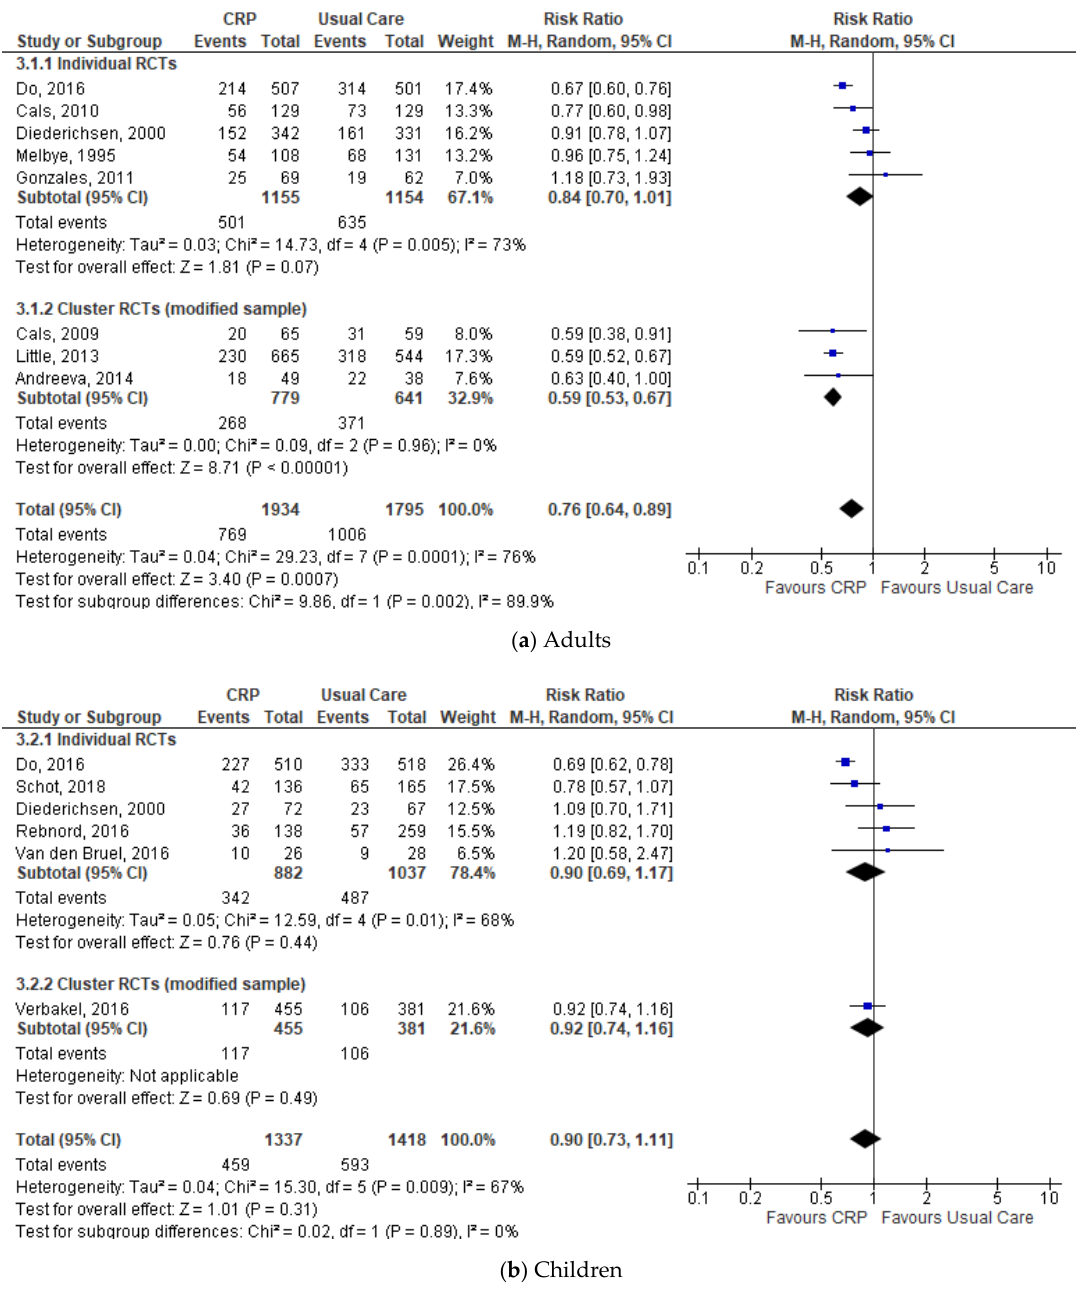
Figure 4. Comparison: CRP-POCT versus usual care. Antibiotic prescribing at index consultations by age group: ( a ) Adults; ( b ) Children. CRP, C-Reactive Protein Point Of Care Test; RCTs, Randomised Controlled Trials; M-H, Mantel-Haenszel; CI, Confidence Interval; df, degrees of freedom; I 2 , heterogeneity between trials.